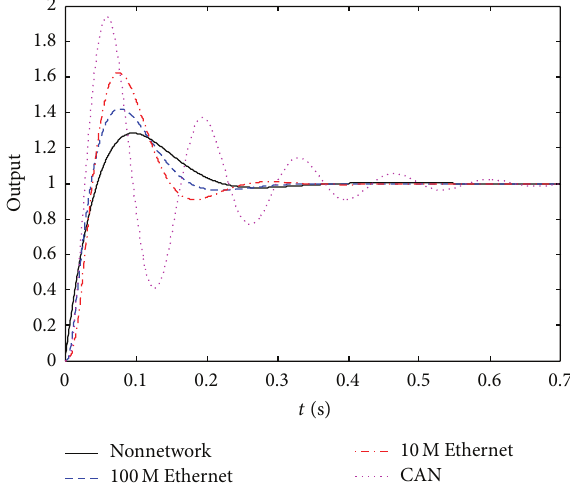
Figure 7: The step responses of the control systems under different network